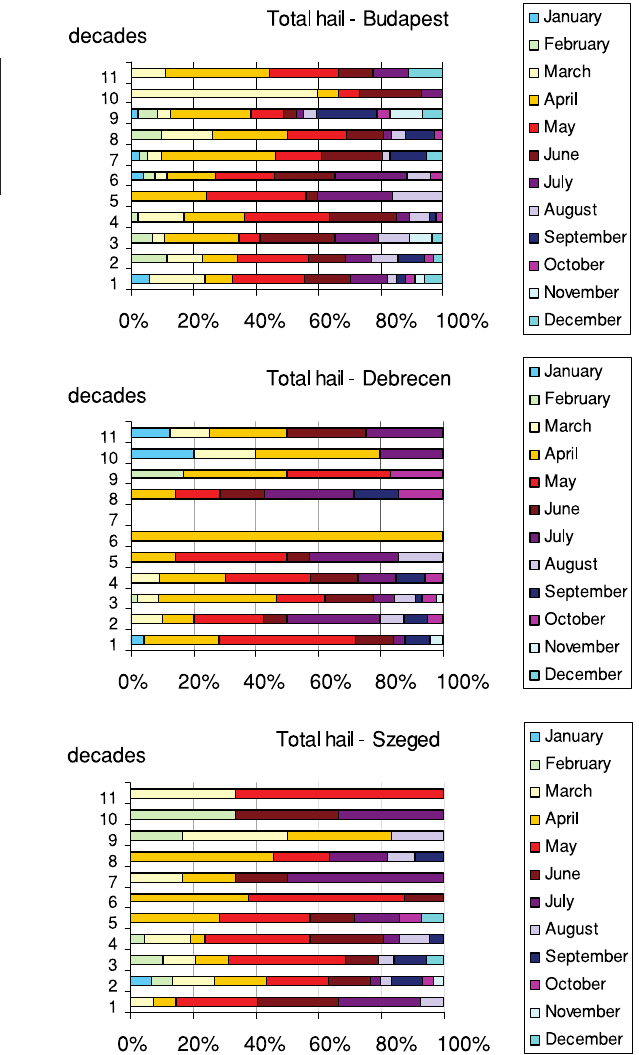
Figure 4: The monthly distribution of hail events per decades (1901-2000) (the last – truncated – decade contains 8 years, only)